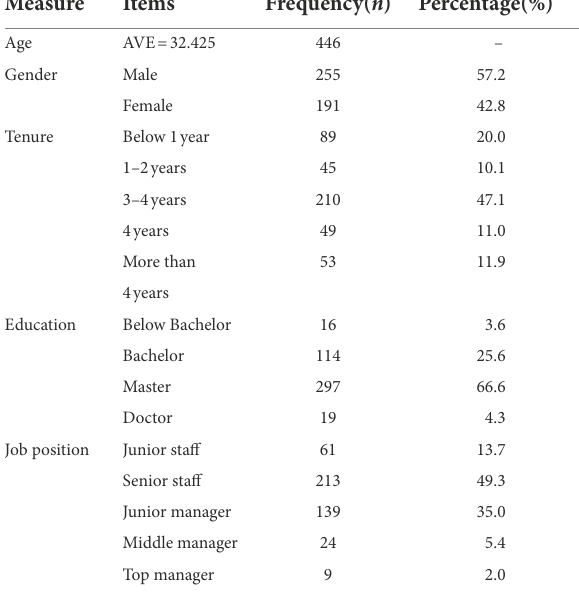
TABLE 1 Participant profile ( N =